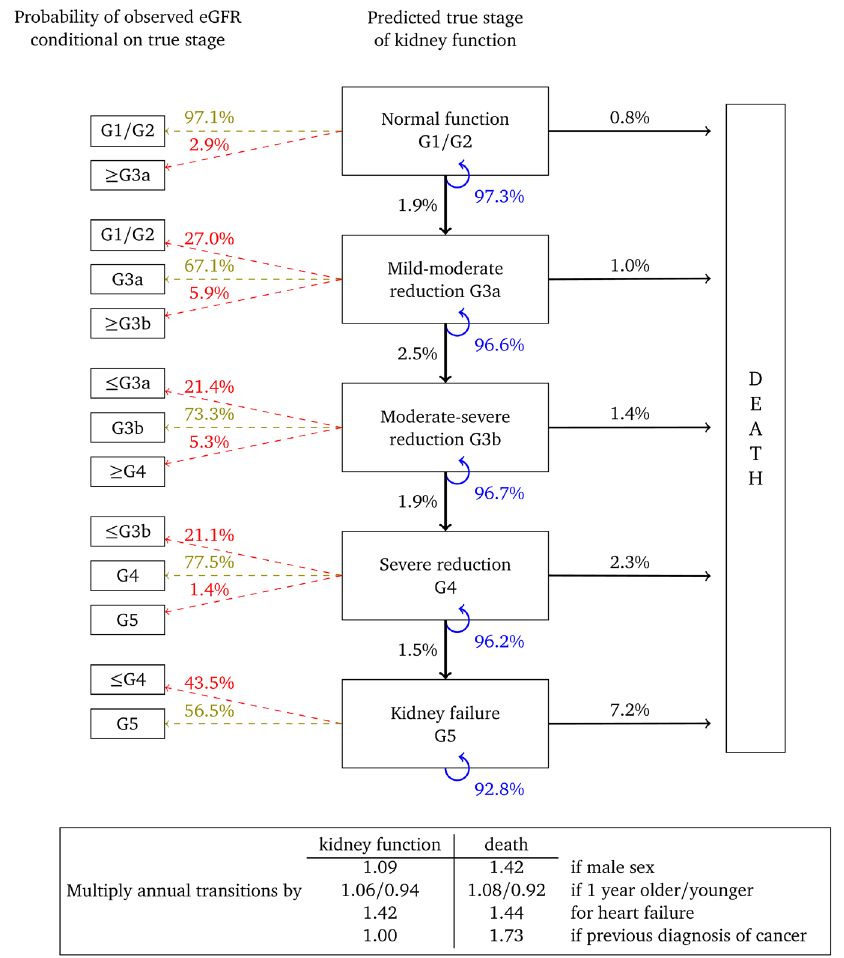
Figure 3. Annual transition model diagram for patients with normoalbuminuria at baseline. Probabilities are based on a woman aged 60, without heart failure or a previous diagnosis of cancer.